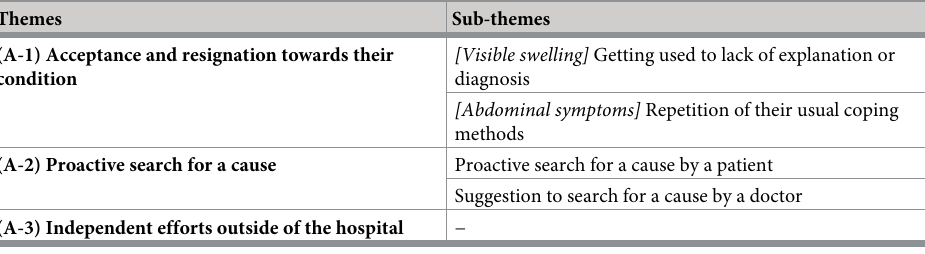
Table 3. Themes and sub-themes of participant experiences